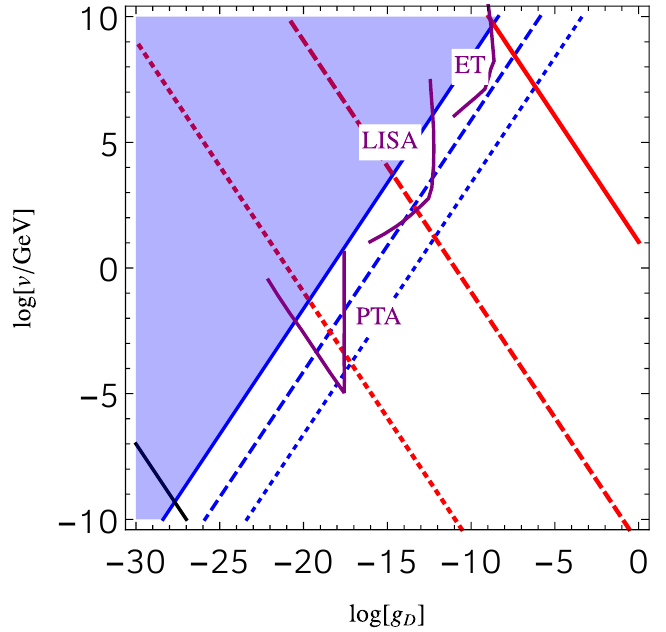
Figure 15 . The observational consequence of a network of string bundles that radiates predominantly gravitational waves. The blue shaded region is excluded by constraints on the gravitational wave energy density from the measurement of the effective number of neutrino species N eff [72], corresponding to dark photon dark matter overclosing the universe before the dynamics we discuss here take place. The blue dashed and dotted lines are N eff of 10 − 5 and 10 − 10 . The red solid, dashed, and dotted lines show the peak frequency of the gravitational wave of kilohertz, millihertz, and yr − 1 , respectively. We also show corresponding near term projections for some future gravitational wave detectors (ET, LISA, and a pulsar timing array with SKA, respectively) as solid purple curves [73]. Below the black solid line, the dynamics we discuss here occurs after matter-radiation